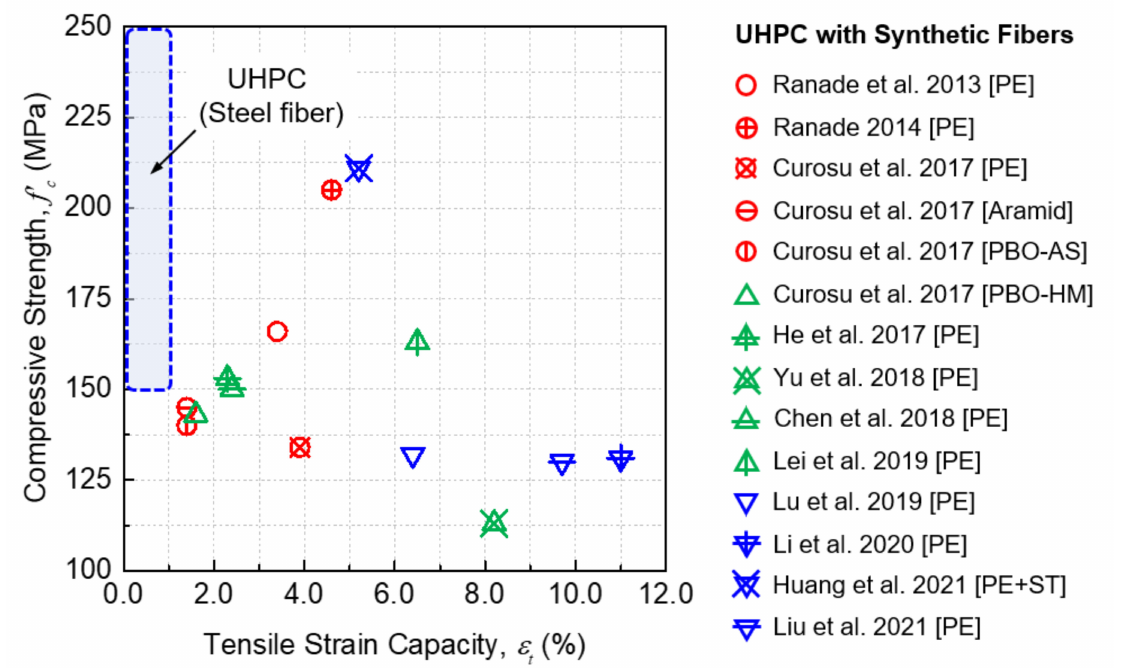
Figure 4. Compressive strength vs. tensile strain capacity relations of strain-hardening UHPC with synthetic fibers in existing